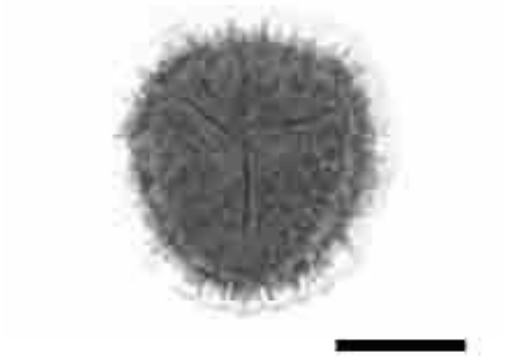
F IGURE 6. Lycopodium clavatum C. Linnaeus spore in polar view. Bar = 20